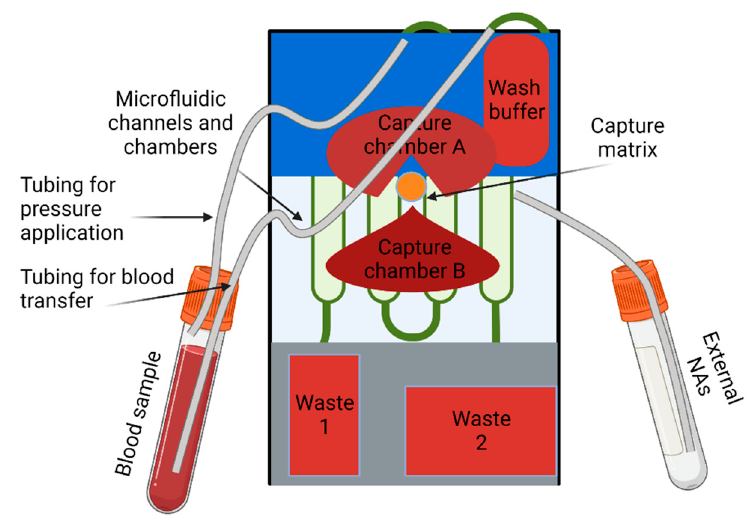
Figure 4. The schematic of the LOAD device combined with pneumatic valves.